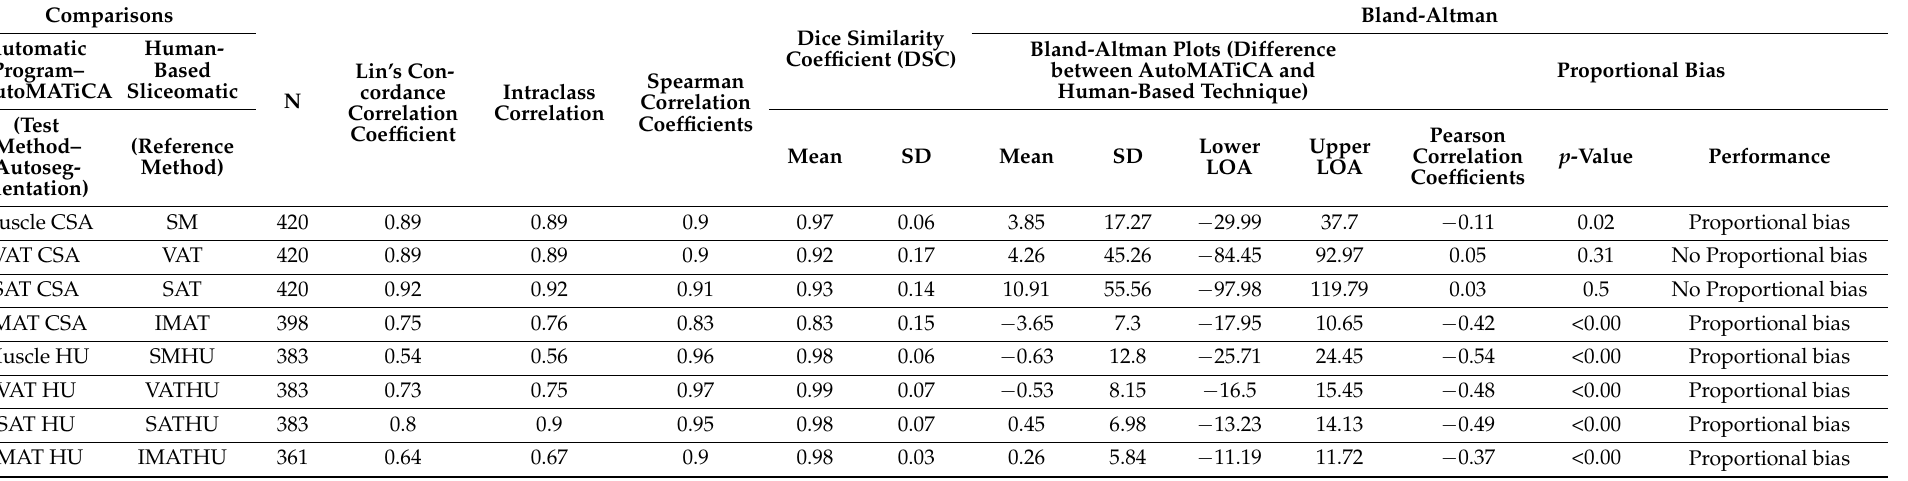
Table 3. Summary of correlation and agreement statistics for patient cohort measured by Lin’s concordance correlation coefficient, intra-class correlation, Spearman correlation coefficients, and Bland-Altman summary statistics including assessment of proportional bias using Pearson correlation